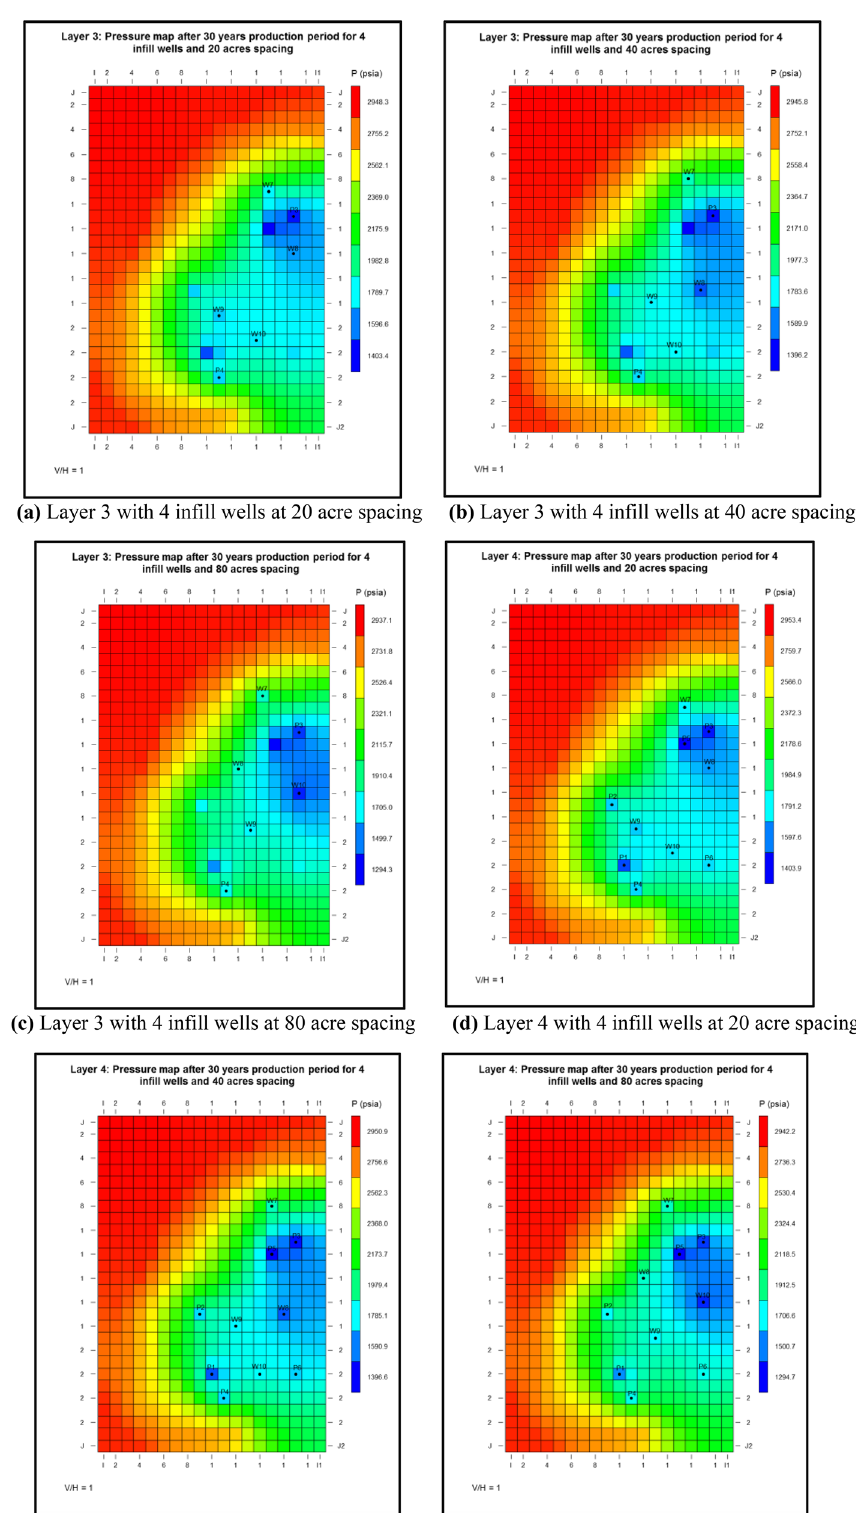
Fig. 16 Pressure distribution maps for layers of the reservoir with 4 infill wells located at dif- ferent well spacings (additional 15 years simulated production